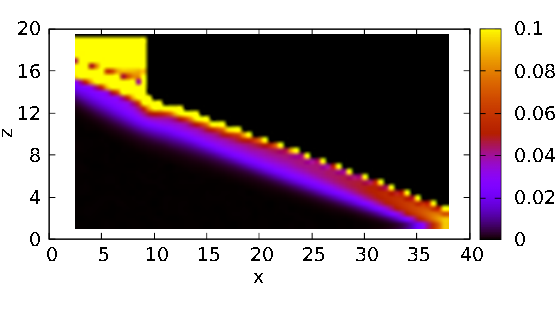
Figure 6. Spatial distribution of inertial number for mass flow rate of 76.0 g / s. Colour scale for the distribution is provided on the right hand side. Qualitatively similar distributions are ob- tained for the other flow rates also.